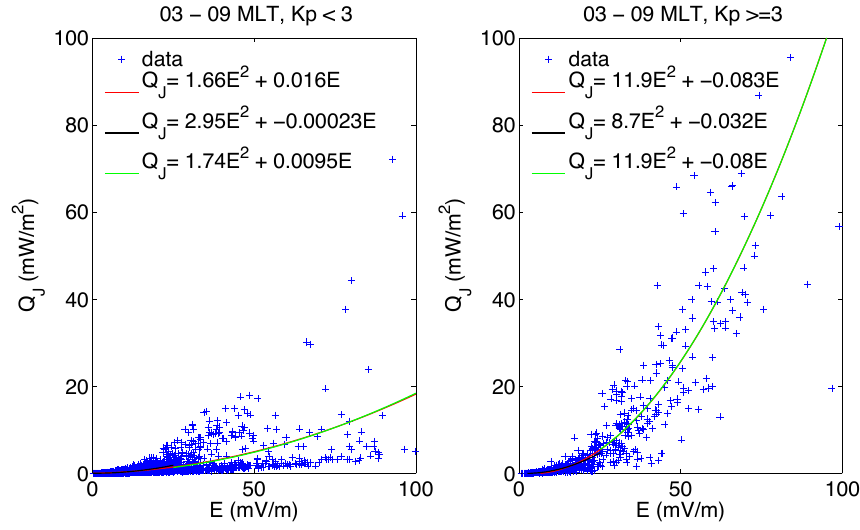
Fig. 16. Same as Fig. 14, but in the midnight sector.